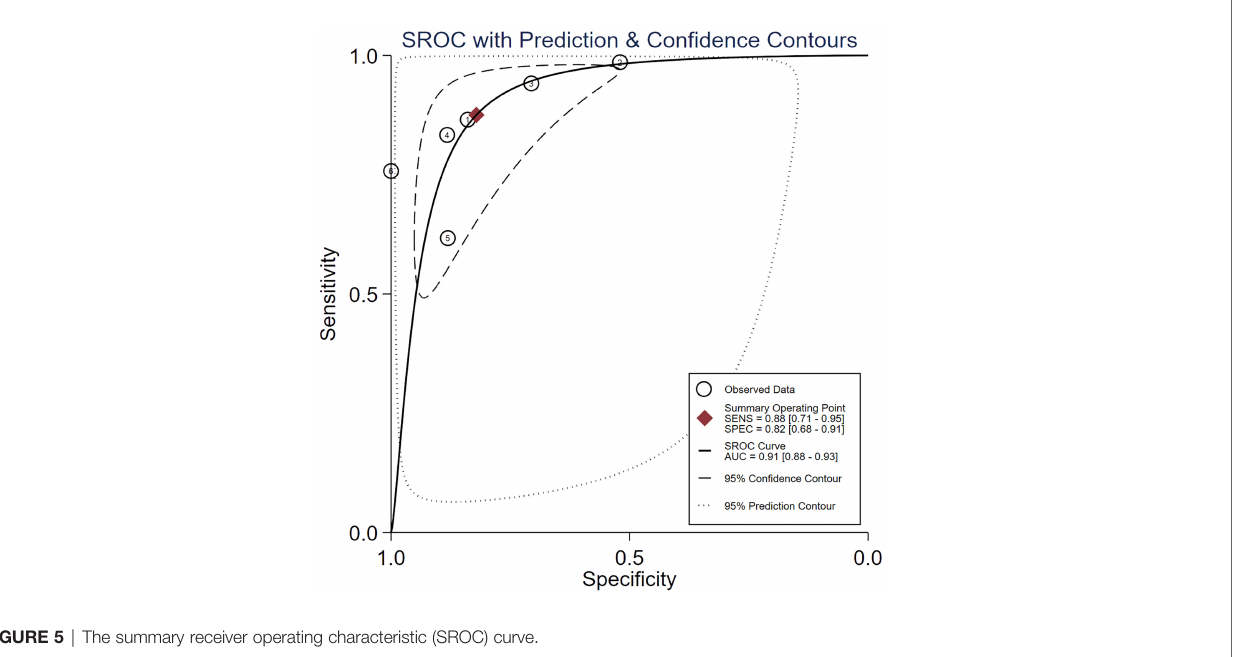
FIGURE 5 | The summary receiver operating characteristic (SROC)